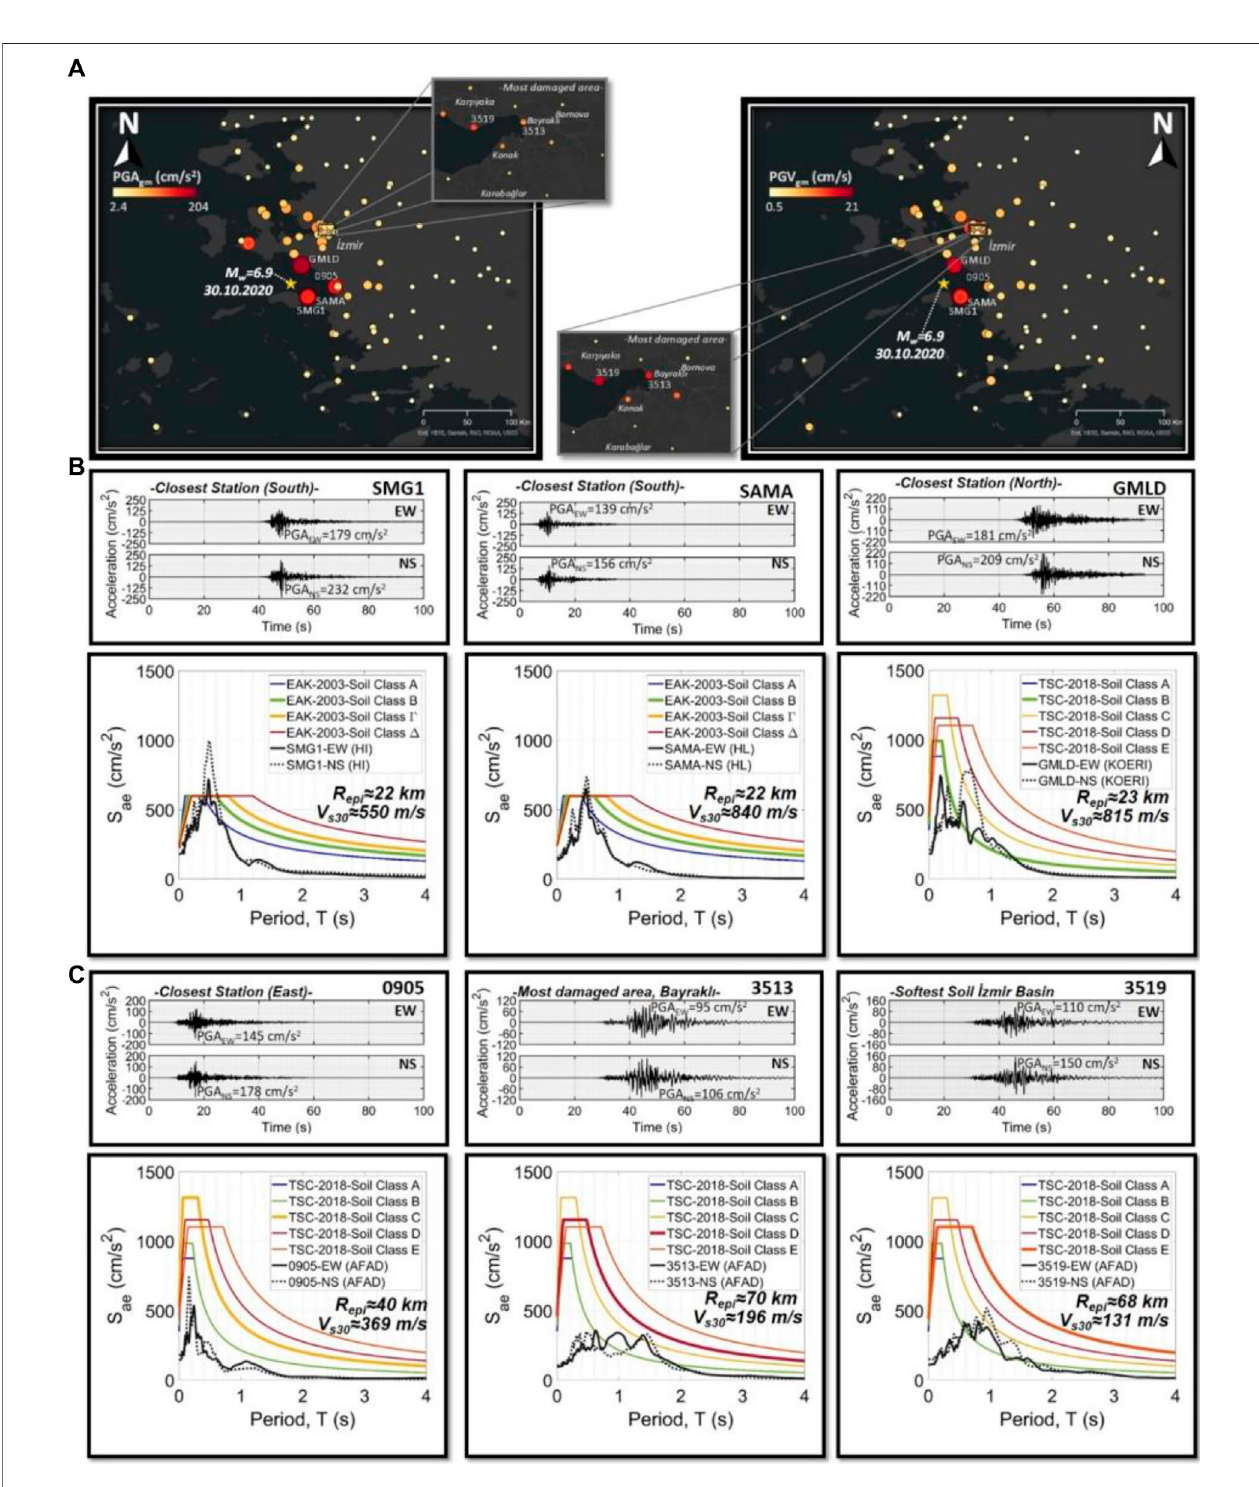
FIGURE7|(A) Spatial distribution oftheobserved PGAsand PGVs withafocusviewon thesigni fi cantlydamagedregion:Bayrakl ı , (B) Acceleration-timehistories and responsespectra oftwo horizontal componentsbelonging to closest stations on South (SMG1 and SAMA) and North (GMLD) of theepicentre, (C) those belonging to the closest station on East (0905) and two stations in Bayrakli (3513 and 3519).